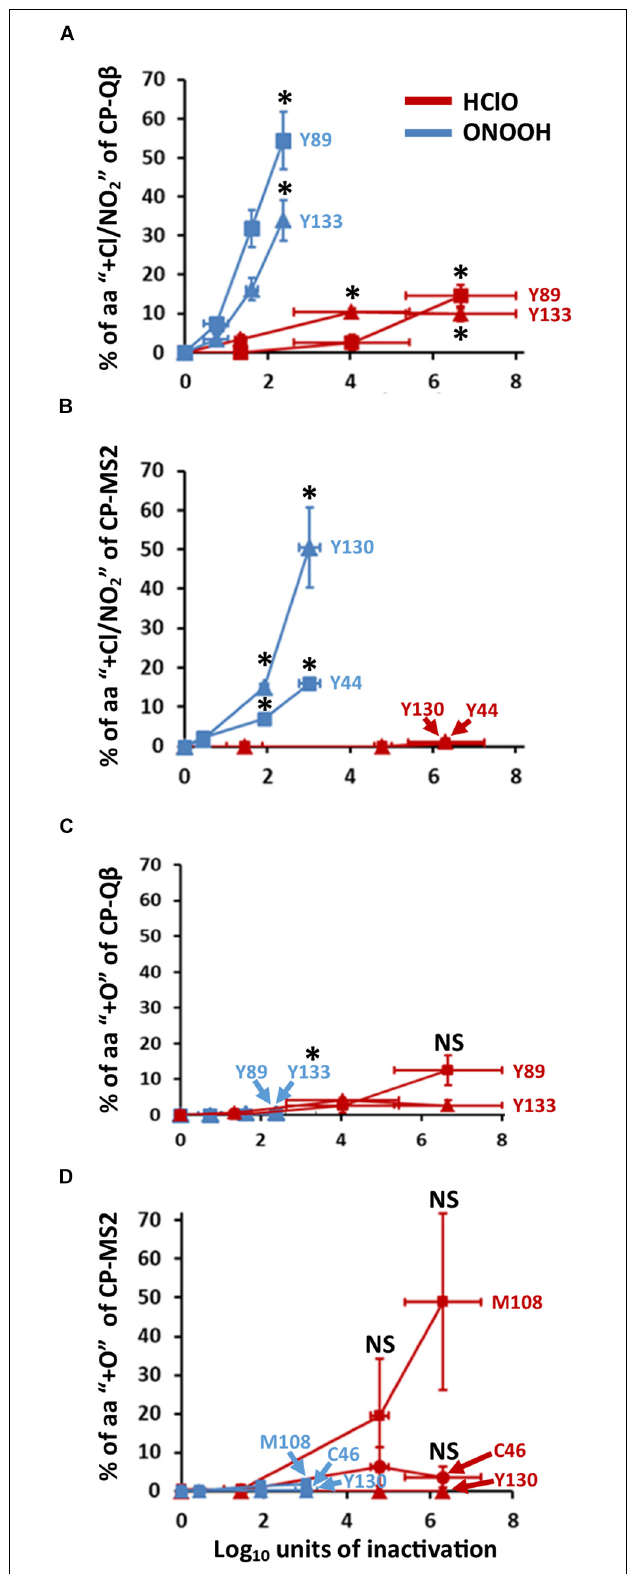
FIGURE 4 | HClO and ONOOH stably oxidize C, M, Y, W. The curves represent the percentage of indicated residues which are stably oxidized. The addition of chloride adducts -for HClO treatment- and nitration -for ONOOH treatment- is represented in (A) for Q β , and (B) for MS2. The addition of oxygen atoms is represented in (C) for Q β , and (D) for MS2. The curves in blue are for ONOOH and those in red are for HClO. The identities of the residues of CPs which were modified are indicated accordingly. Each point of the curves is representative of three independent experiments carried out in separate days. Error bars stand for SEM. Where indicated * p < 0.05 as compared to control, the statistical tests are described in “Materials and Methods” section of this manuscript.